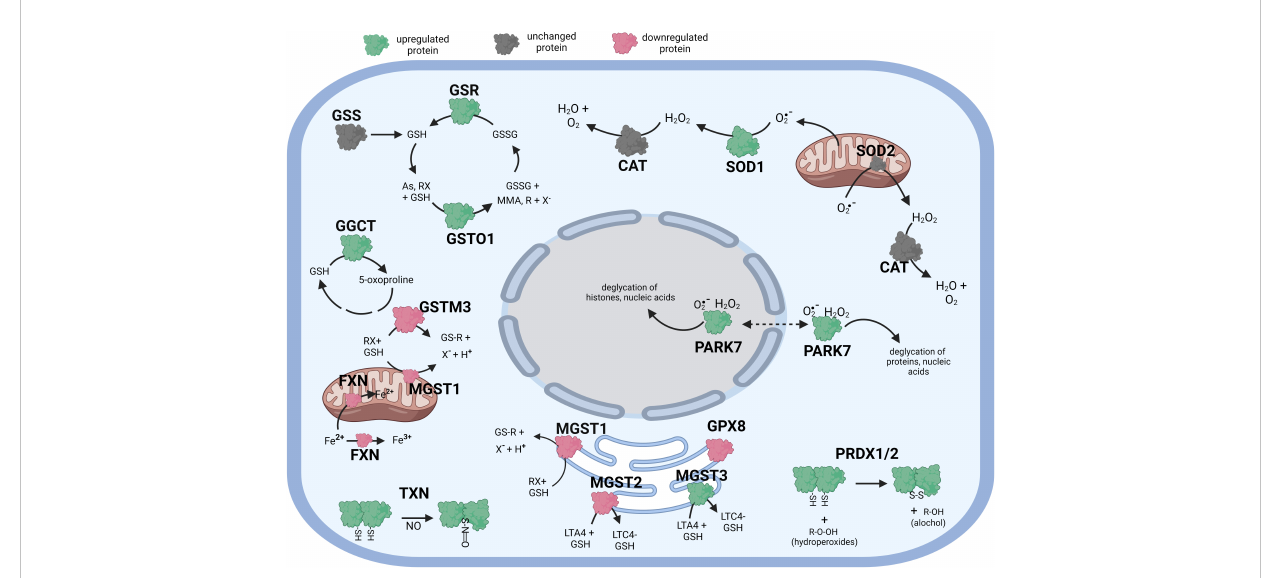
FIGURE 3 Diagramatic summary of the effect of g T exposure on antioxidant protein expression in hTERT-RPE cells. The antioxidant proteins focused on in this study are either upregulated (green), downreuglated (red) or unaffected (no change in expression) (grey) by exposure to g T. The arrows indicate athe direction of a chemical reaction. Exposure of hTERT RPE cells to g T led to an increase in several proteins involved in glutathione homeostasis and transfer including GSR, GGCT, GSTO1 and MGST3. Exposure to g T also incerased the expression of PRDX1, PRDX2, SOD1, TXN and PARK7. Figure created with BioRender.com.